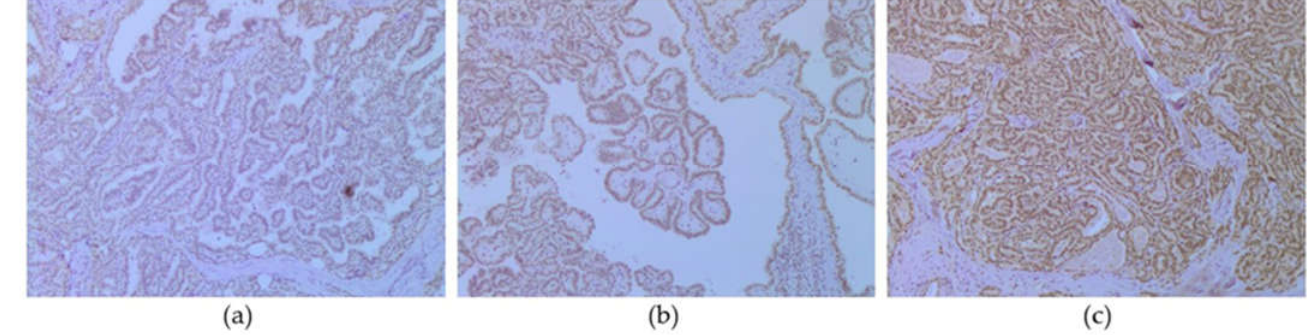
Figure 1. CPSF2 protein expression. ( a ) CPSF2 1+, weak (CPSF2, ABC, ×100), ( b ) CPSF2 2+, moderate (CPSF2, ABC, ×200), ( c ) CPSF2 3+, strong (CPSF2, ABC,